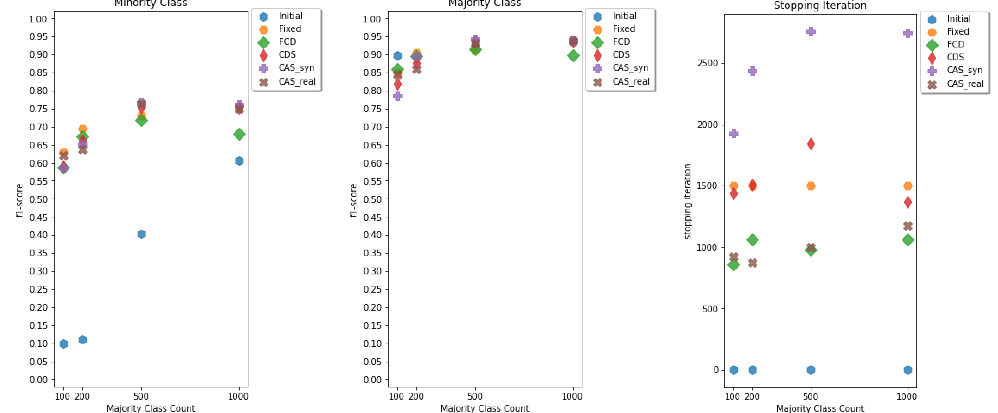
Figure 11. Average F1 results of tor-based datasets by majority class count for minority ( left ) and majority ( center ) classes, and average number of iterations until the training is stopped ( right ).